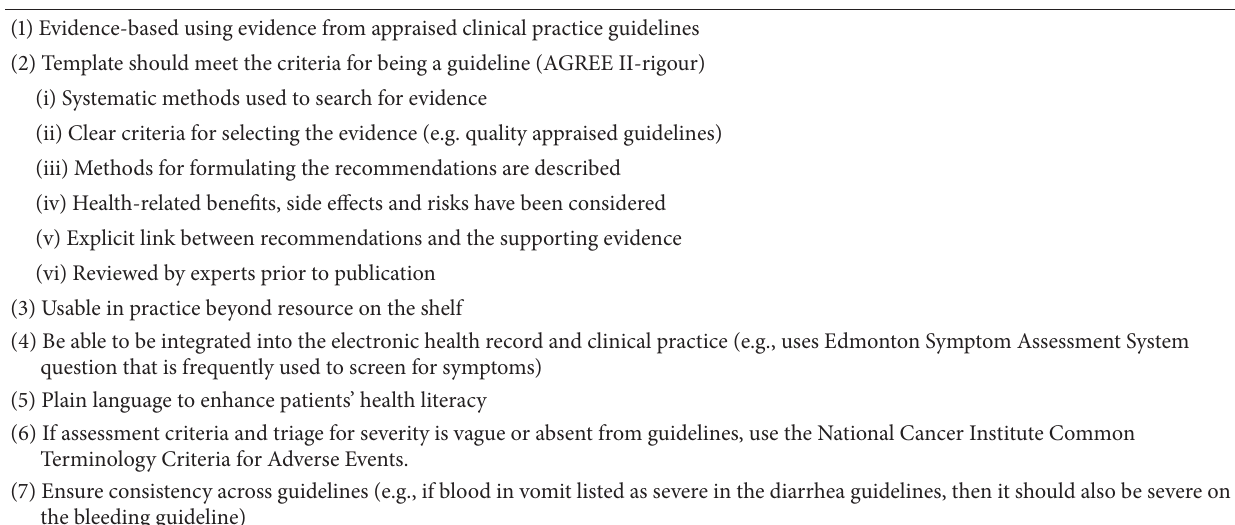
Table 5: Principles for clinical nursing protocol template